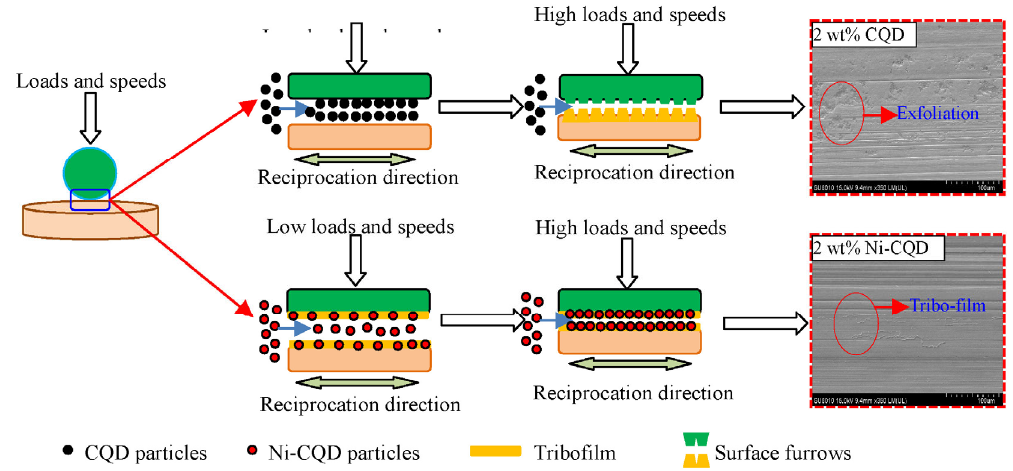
Fig. 14 Friction and wear mechanisms of CQD and